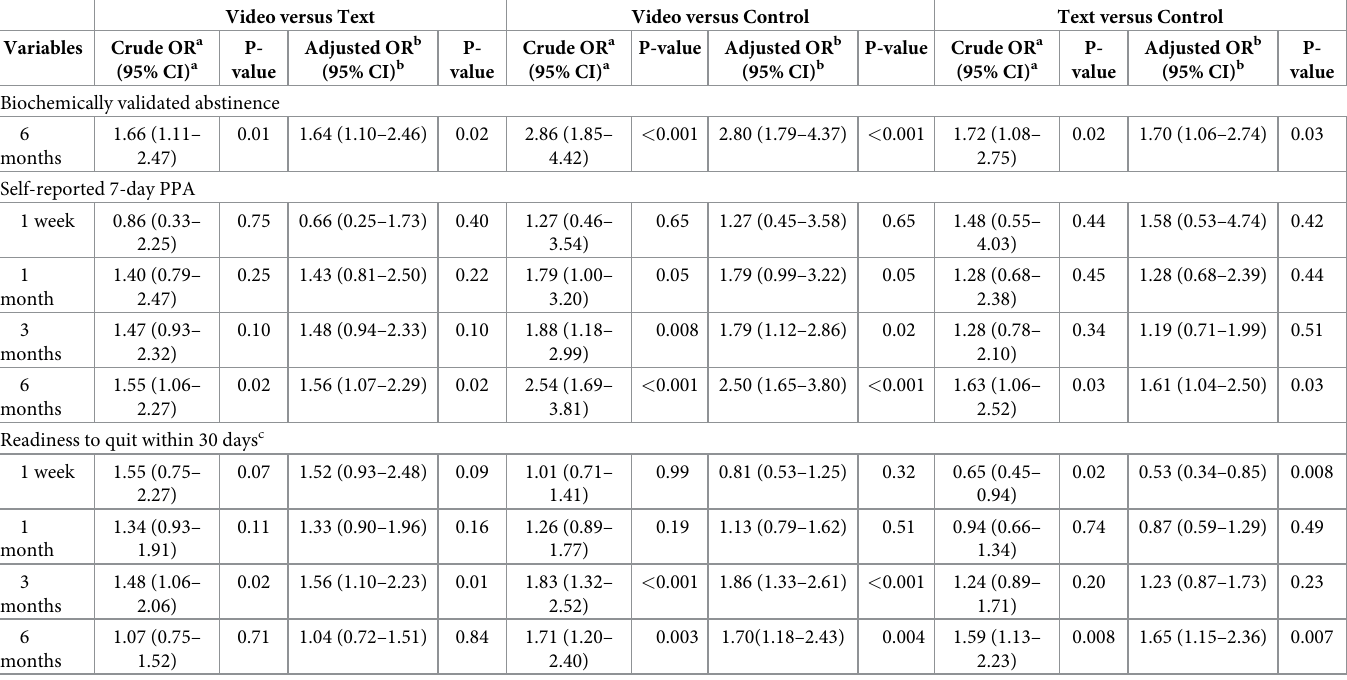
Table 3. GEE model for smoking cessation outcomes among 1,023